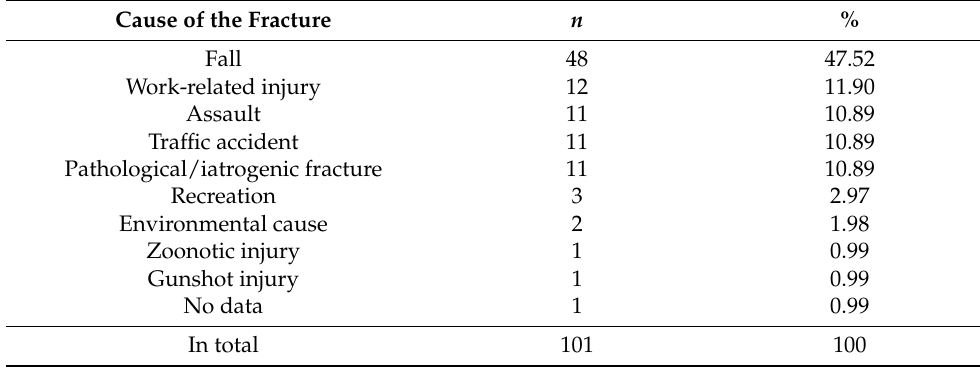
Table 3. Cause of the fracture.